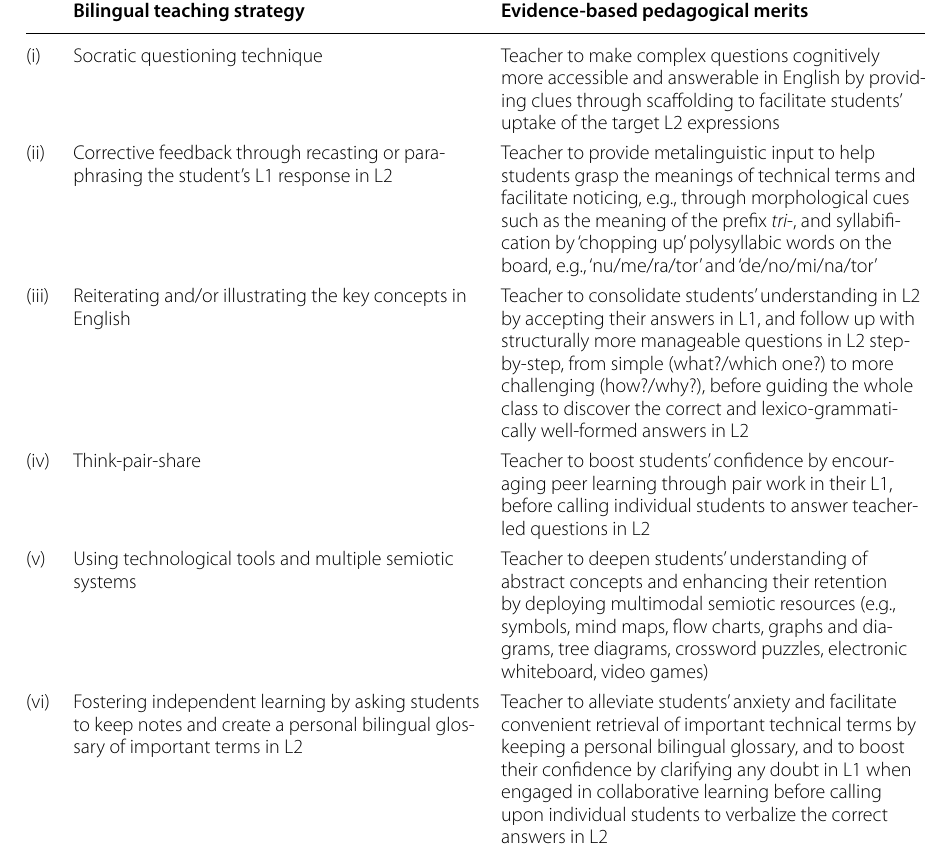
Table 3 Some exemplary bilingual pedagogies and instructional strategies (based on a discussion paper by Li,